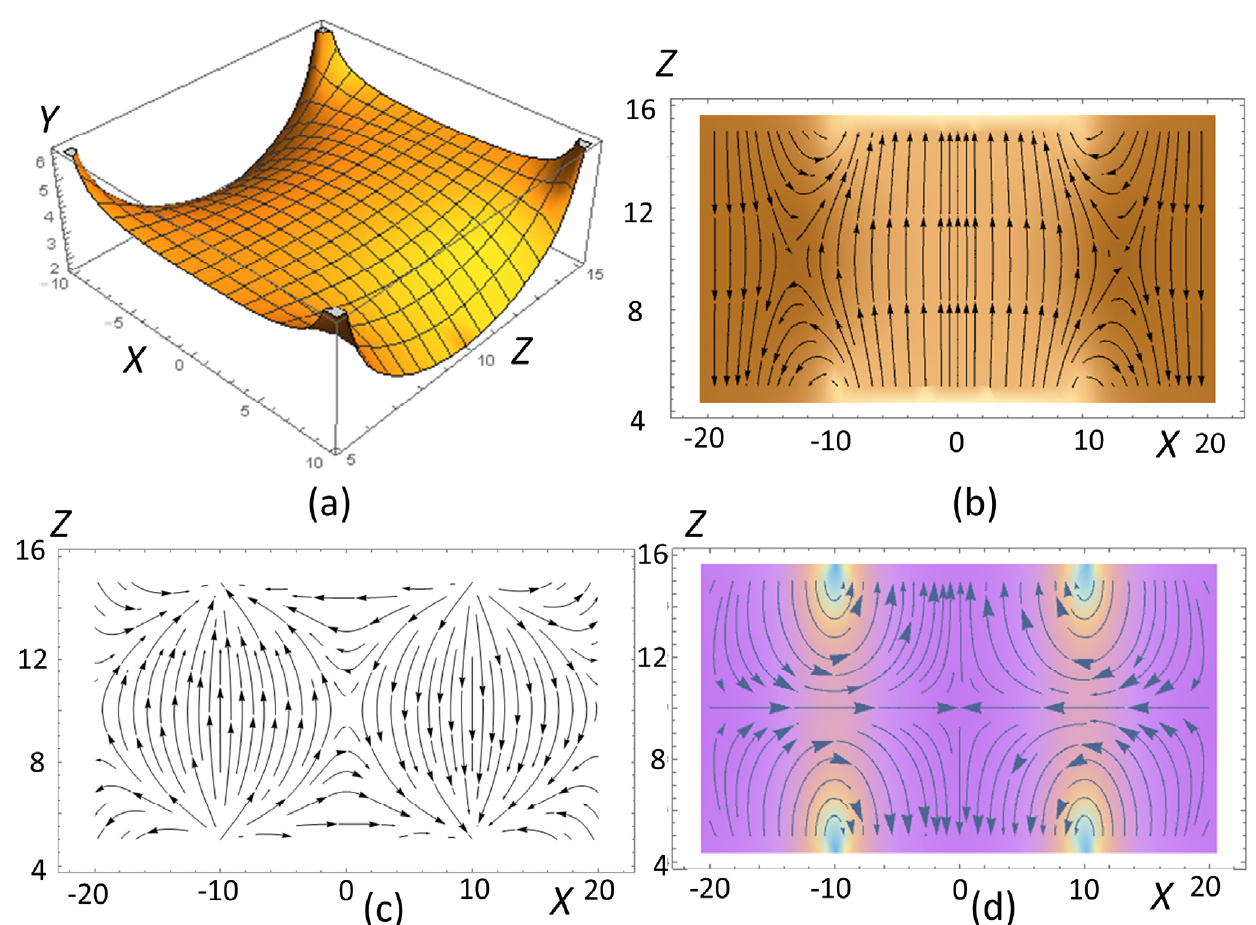
Figure 2. Spatial magnetic field and gradient distributions within a magnetic unit of the bacteria cultivation system: ( a ) 3D plot of the magnetic field strength modulus, H/M vs. x - and z -coordinates (both in mm); ( b ) vector field of H vs. x - and z -coordinates in the plane y = 0; ( c ) vector field of dH/dx vs. the x - and z -coordinates in the plane y = 0; ( d ) vector field of dH/dz vs. the x - and z -coordinates in the plane y = 0.